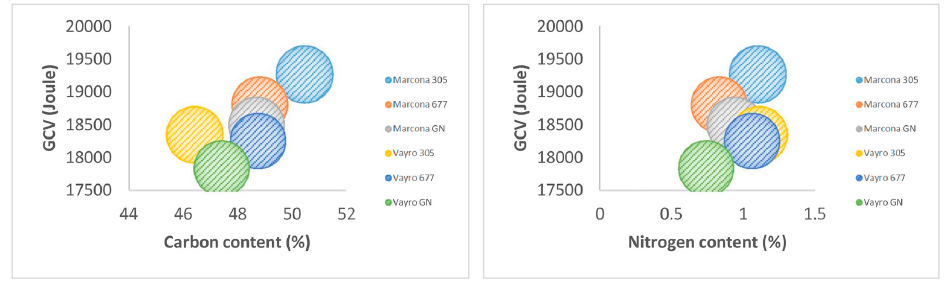
Figure 3. Dispersion diagram for gross calorific values (J·g − 1 ) according to the carbon and nitrogen content for each variety-rootstock combination.